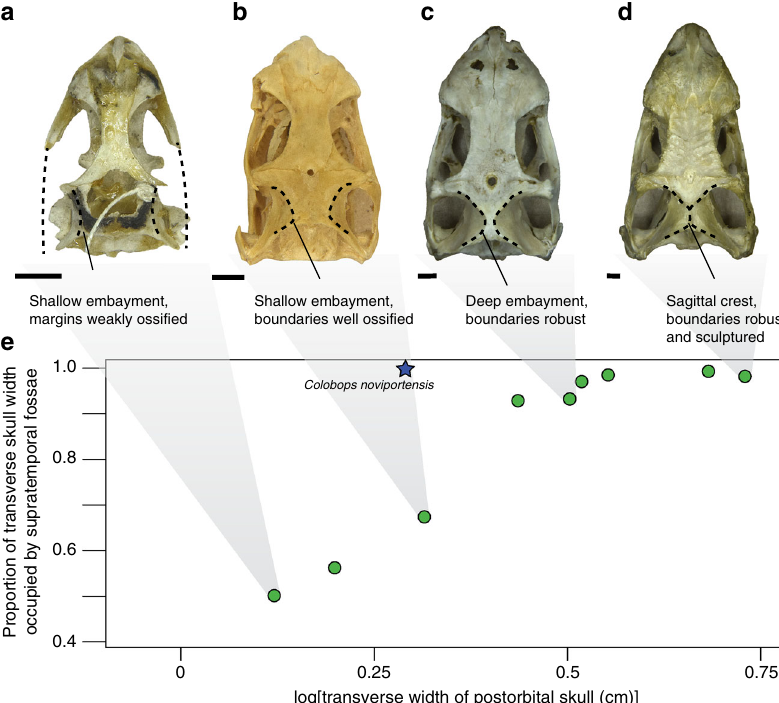
Fig. 4 Plot of relative width of supratemporal fossae by total skull width in modern Iguana . Skulls of Iguana iguana in dorsal view, representing an ontogenetic series illustrating the broadening of the attachments of the adductor musculature (including a USNM VZ 220232, b USNM VZ 220231, c USNM VZ 220236, d USNM VZ 70470) and e bivariate plot of the transverse width of the postorbital portion of the skull (measured at the anteroposterior midpoints of the supratemporal fenestrae) against the proportional contribution of the supratemporal fossae to the transverse width of the postorbital portion of the skull using data from Iguana iguana . Shaded indicators indicate correspondence between data points and the photographs of the individual skulls. The star on the plot indicates the position of Colobops noviportensis (YPM VPPU 18835) in morphospace. Scale bars equal to 5